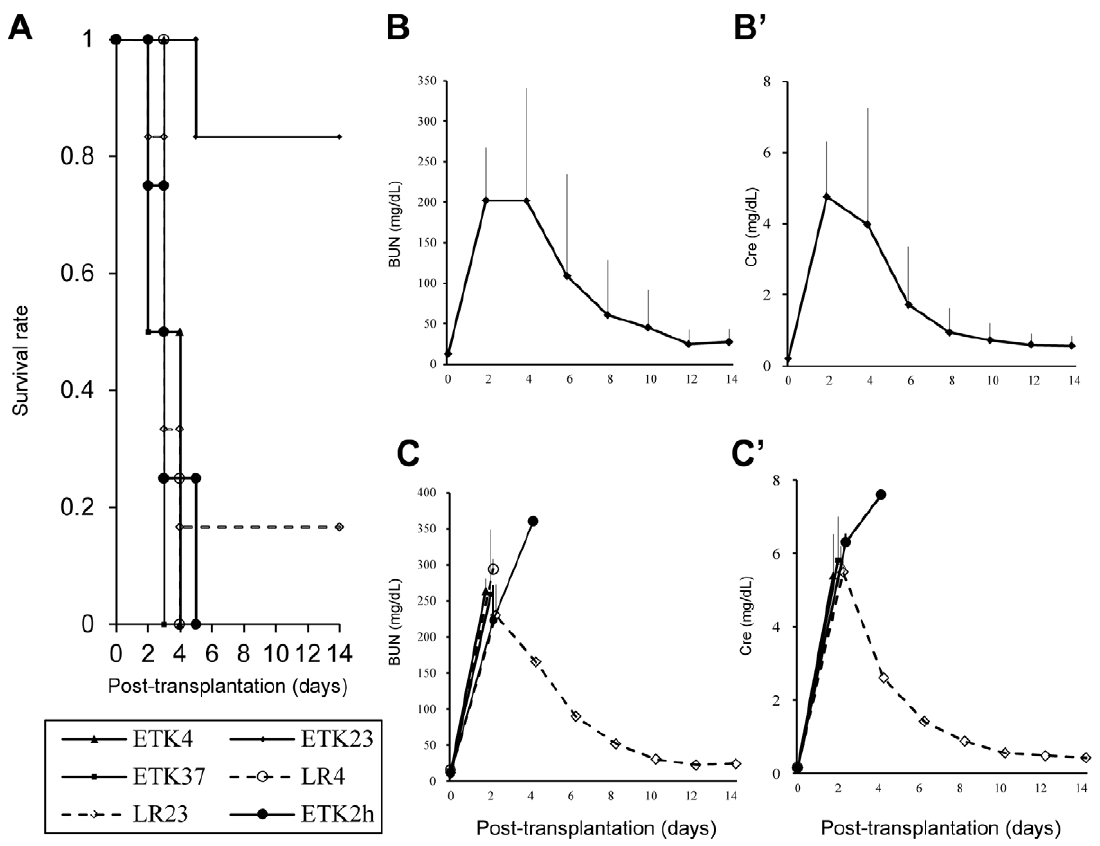
Figure 2. Survival rate, blood urea nitrogen (BUN) and serum creatinine (Cre) levels in experiment 2. (A): Survival rate of each group. Survival rate of the group receiving kidneys preserved with ET-Kyoto solution (ETK) for 1 h at 23 u C (ETK23 group) was significantly longer than that of the other groups ( # p , 0.01 using Log-Rank test.). (B): BUN and (B’): Cre of the ETK23 group. (C): BUN and (C’): Cre of the other groups without EK23. In all groups in experiment 2, BUN and Cre of all surviving rats reached a peak at day 2 and recovered to a nearly normal range by day 14. (BUN and Cre of the LR23 group was n=1 after day 4.)